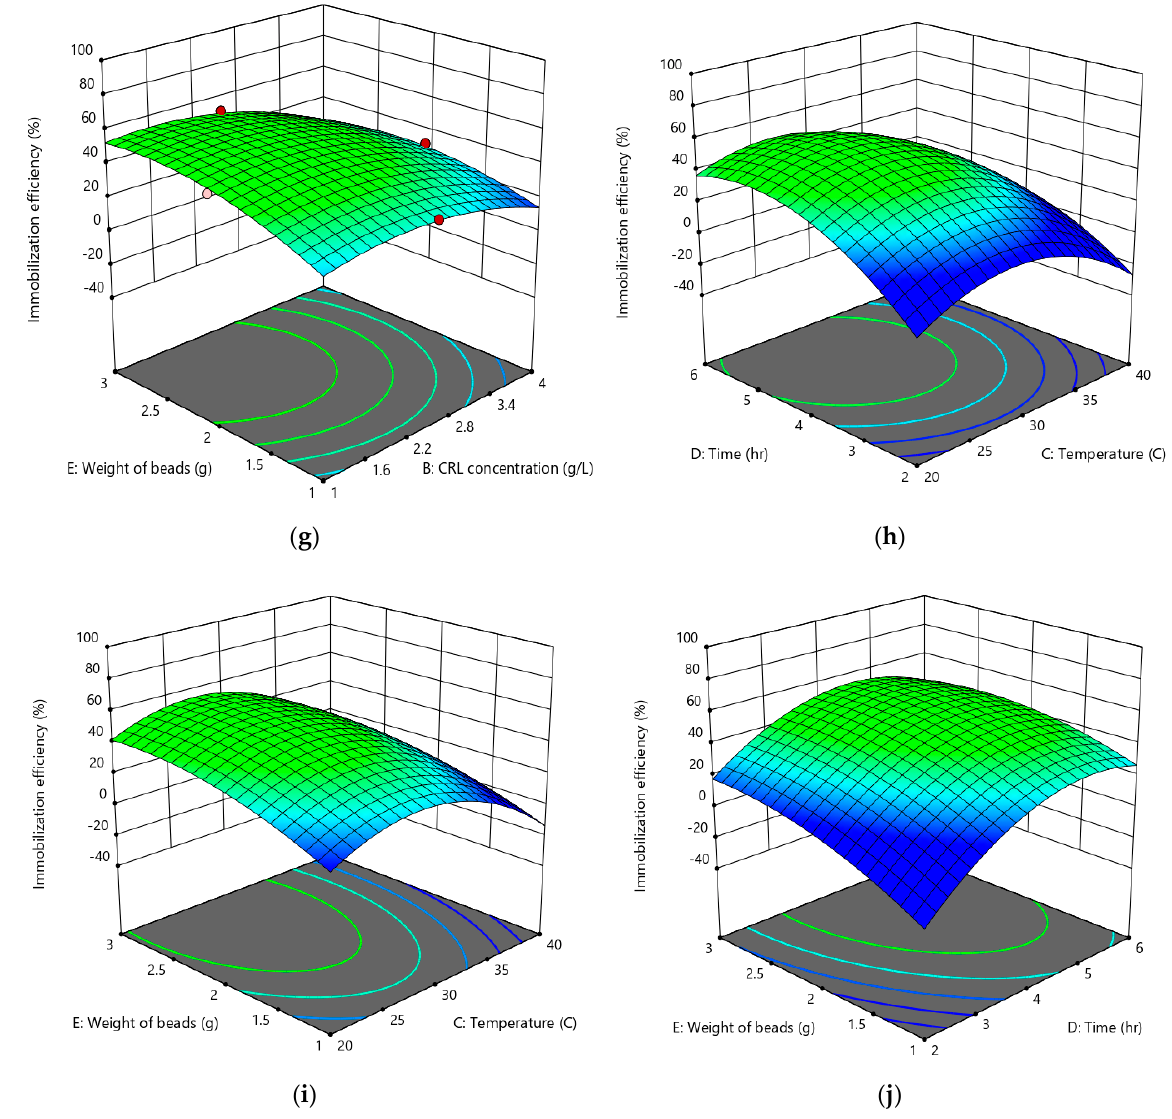
Figure 4. Response surface plot and contour plot for immobilization efficiency showing significant model terms: ( a ) agitation speed vs. CRL concentration, ( b ) agitation speed vs. temperature, ( c ) agitation speed vs. time, ( d ) agitation speed vs. weight of MgO-Al 2 O 3 beads, ( e ) CRL concentration vs. temperature, ( f ) CRL concentration vs. time, ( g ) CRL concentration vs. weight of MgO-Al 2 O 3 beads, ( h ) temperature vs. time, ( i ) temperature vs. weight of MgO-Al 2 O 3 beads, and ( j ) time vs. weight of MgO-Al 2 O 3 beads.